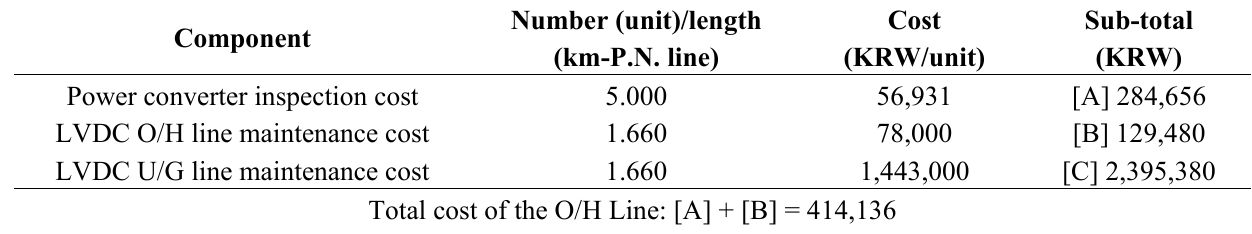
Table 7. Maintenance costs of